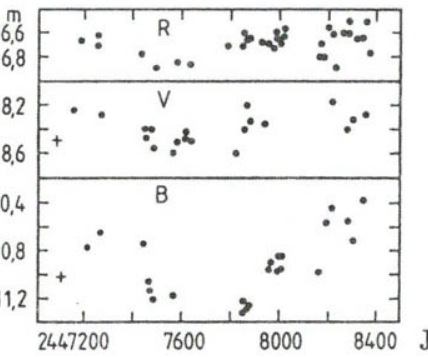
Fig. 9. Λ(0.63)-, V- and ß-magnitudes versus time for BM Gem, crosses are for photoelectric observation by Kizla (1991).